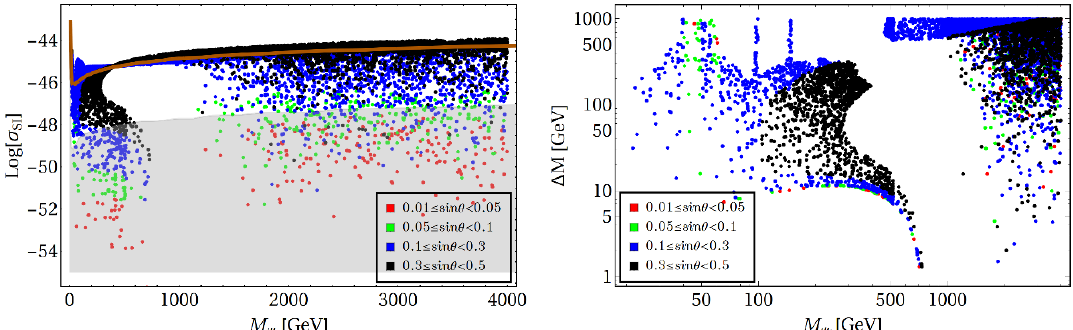
- (cid:27) SI plane for di(cid:11)erent choices of sin (cid:18) 1 -(cid:1) M plane after imposing 1